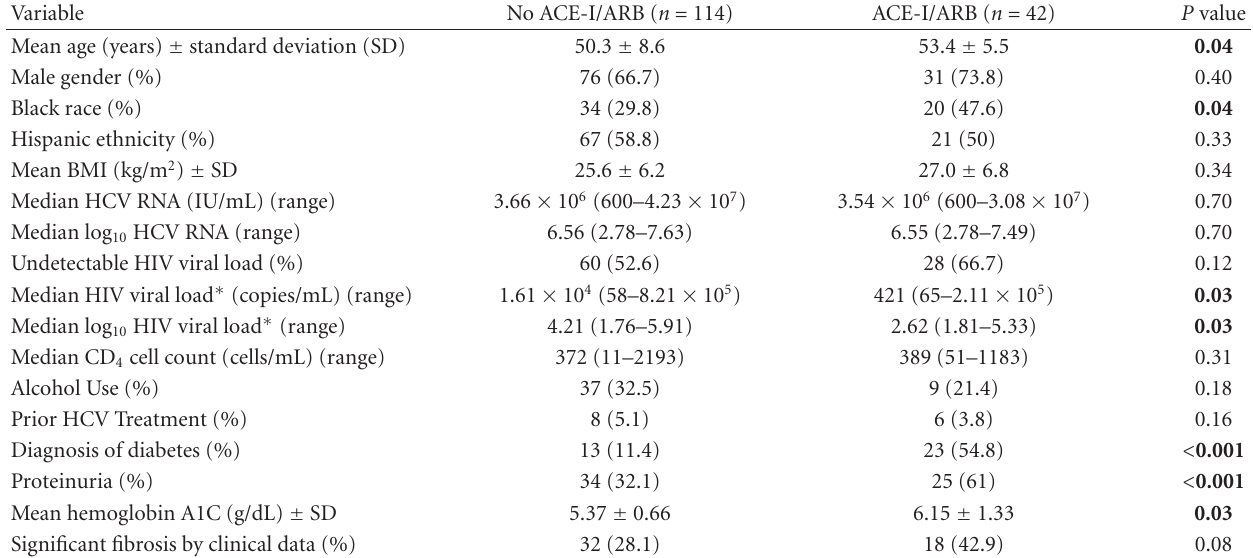
Table 1: Baseline characteristics of 156 subjects characterized by ACE-I/ARB exposure.